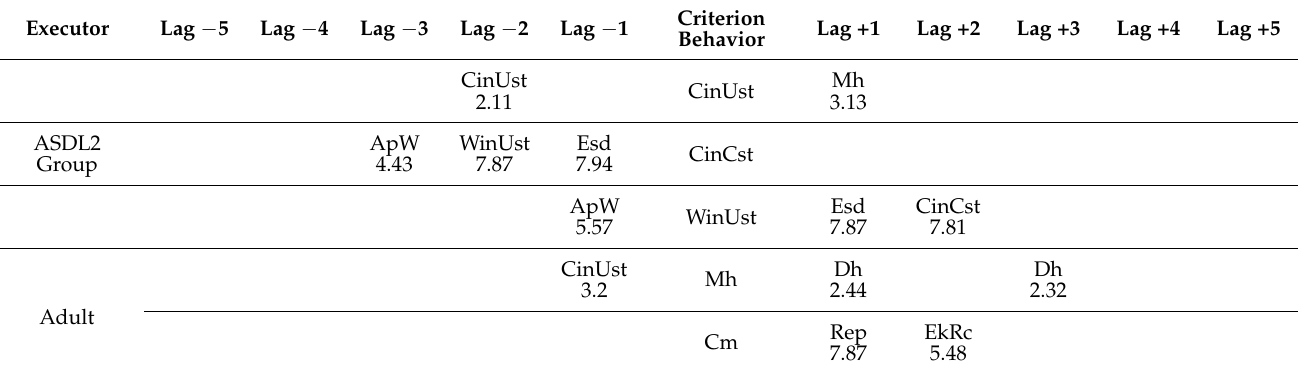
Table 7. Behavioral patterns obtained in the ASDL2 Group in the middle of the intervention. Central column = It contains the criteria behaviors. Remaining cells = They contain the conditional behaviors. Numbers = Significant adjusted residuals values. Green codes = The most relevant behaviors indicating children progress in interference control. Red codes = The most relevant wrong interference control behaviors of the children. Blue codes = The most relevant adult scaffolding behaviors.